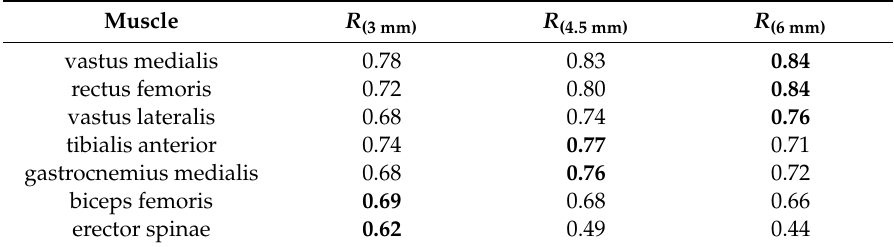
in each muscle are